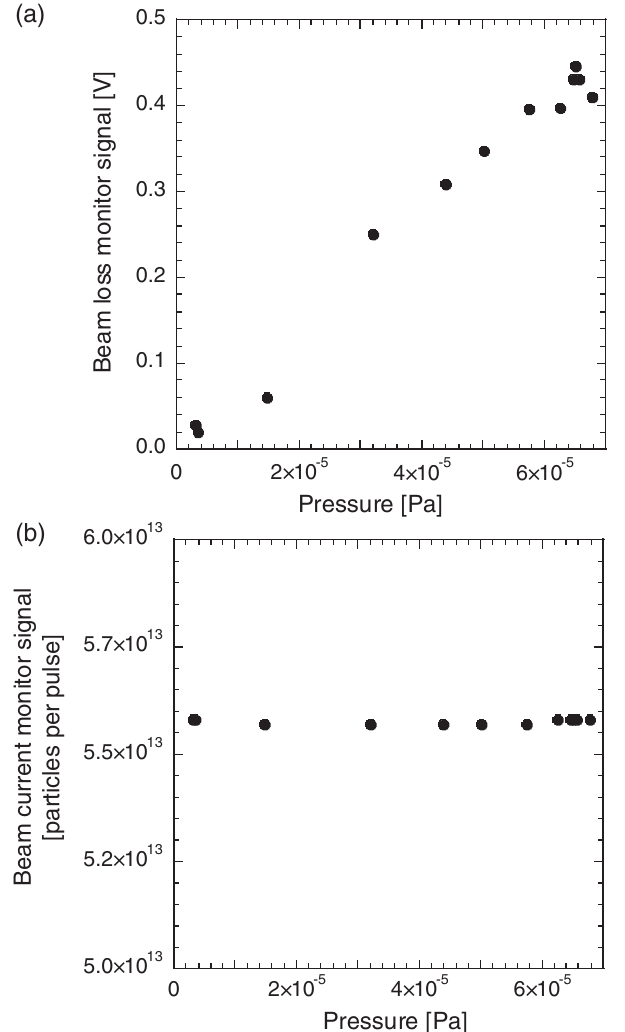
FIG. 7. (a) Example of the correlation between the beam line pressure and the beam loss monitor signal in the 600 kW beam operation of Fig. 5. (b) Example of the correlation between the pressure and the number of protons measured by the beam current monitor in the same period as panel